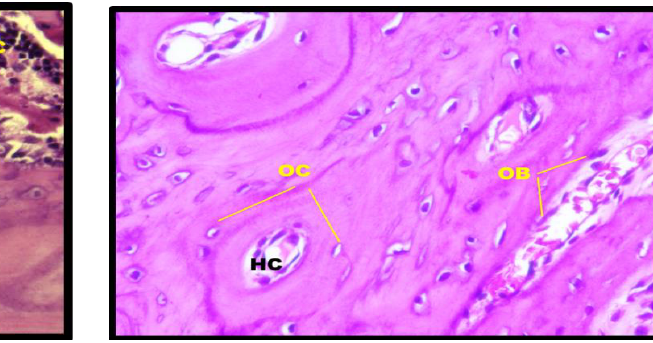
Figure (3): Sponge group at 2-weeks showing new bone trabeculae (BT), osteoclasts (OCL) and inflammatory cells (IC). H&E X40.